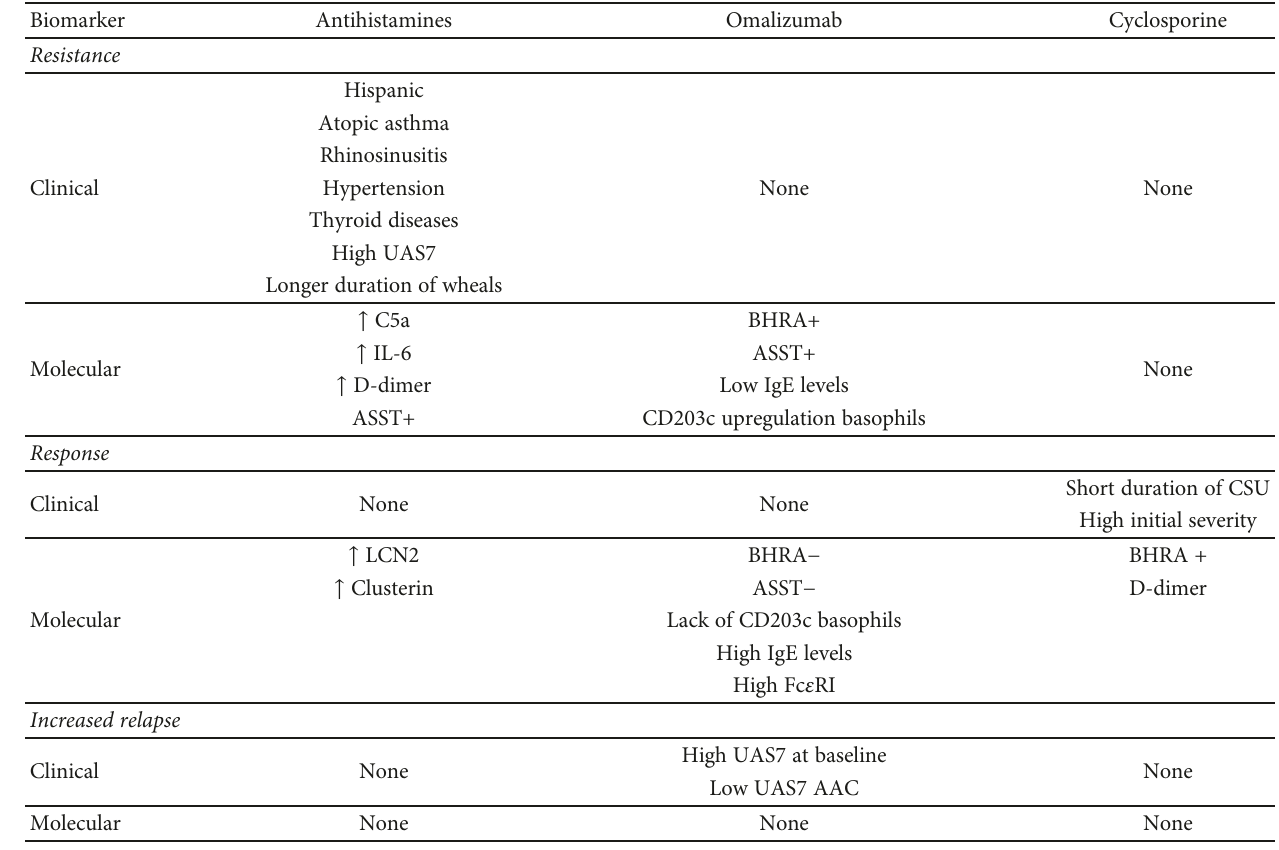
Table 2: Biomarkers with a potential prediction on drug